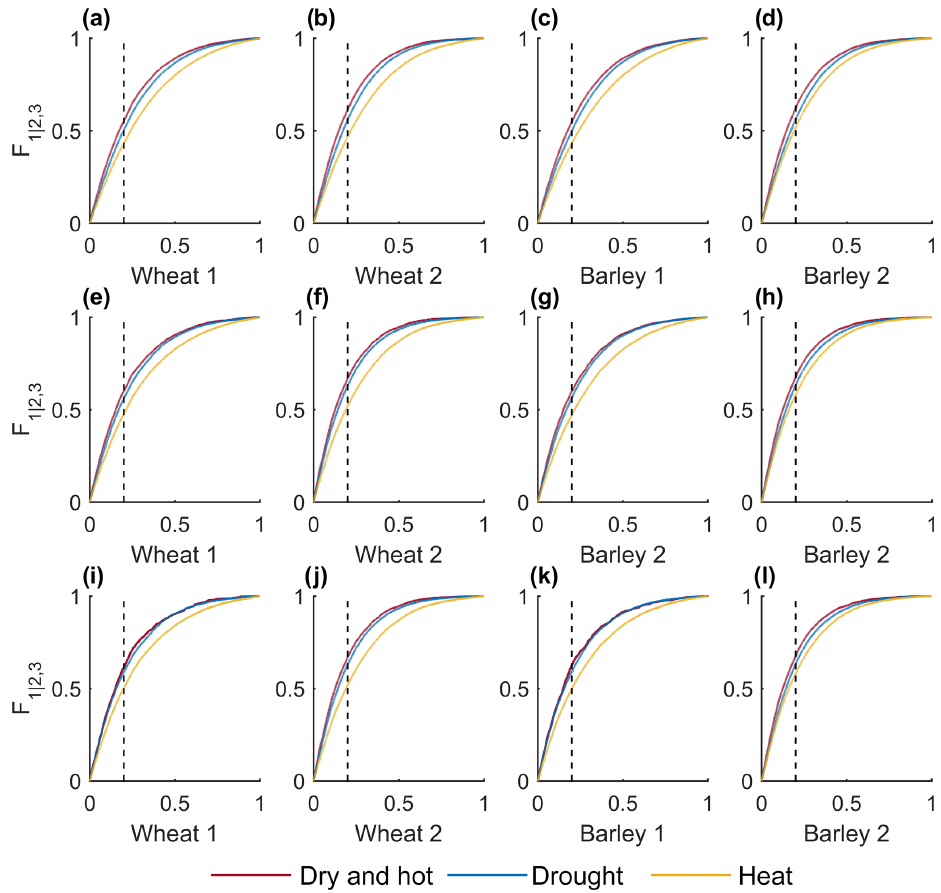
Figure A2. Conditional probability distributions of crop yield anomalies over each region under hot (yellow), dry (blue) or compound dry and hot (red) conditions under moderate (a–d) , severe (e–h) and extreme conditions (i–l) .